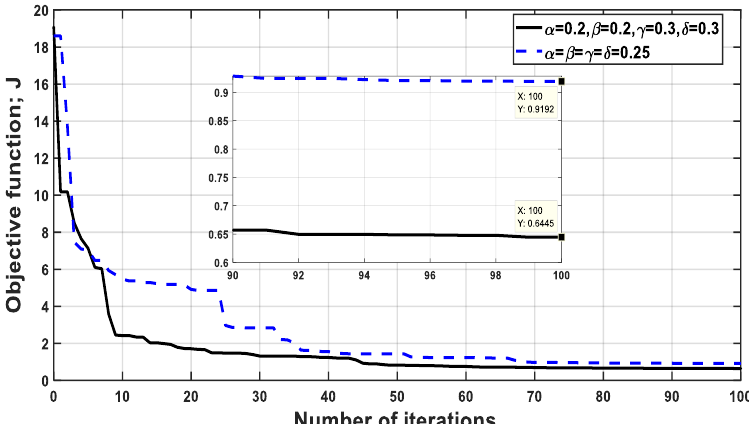
Figure 3. Performance of the objective function under two sets of weighting factors for one TL using the WOA.